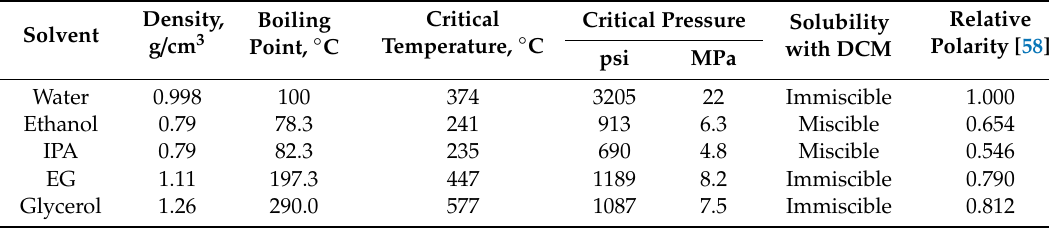
Physical properties of solvents used in hydrothermal liquefaction (HTL) treatment of